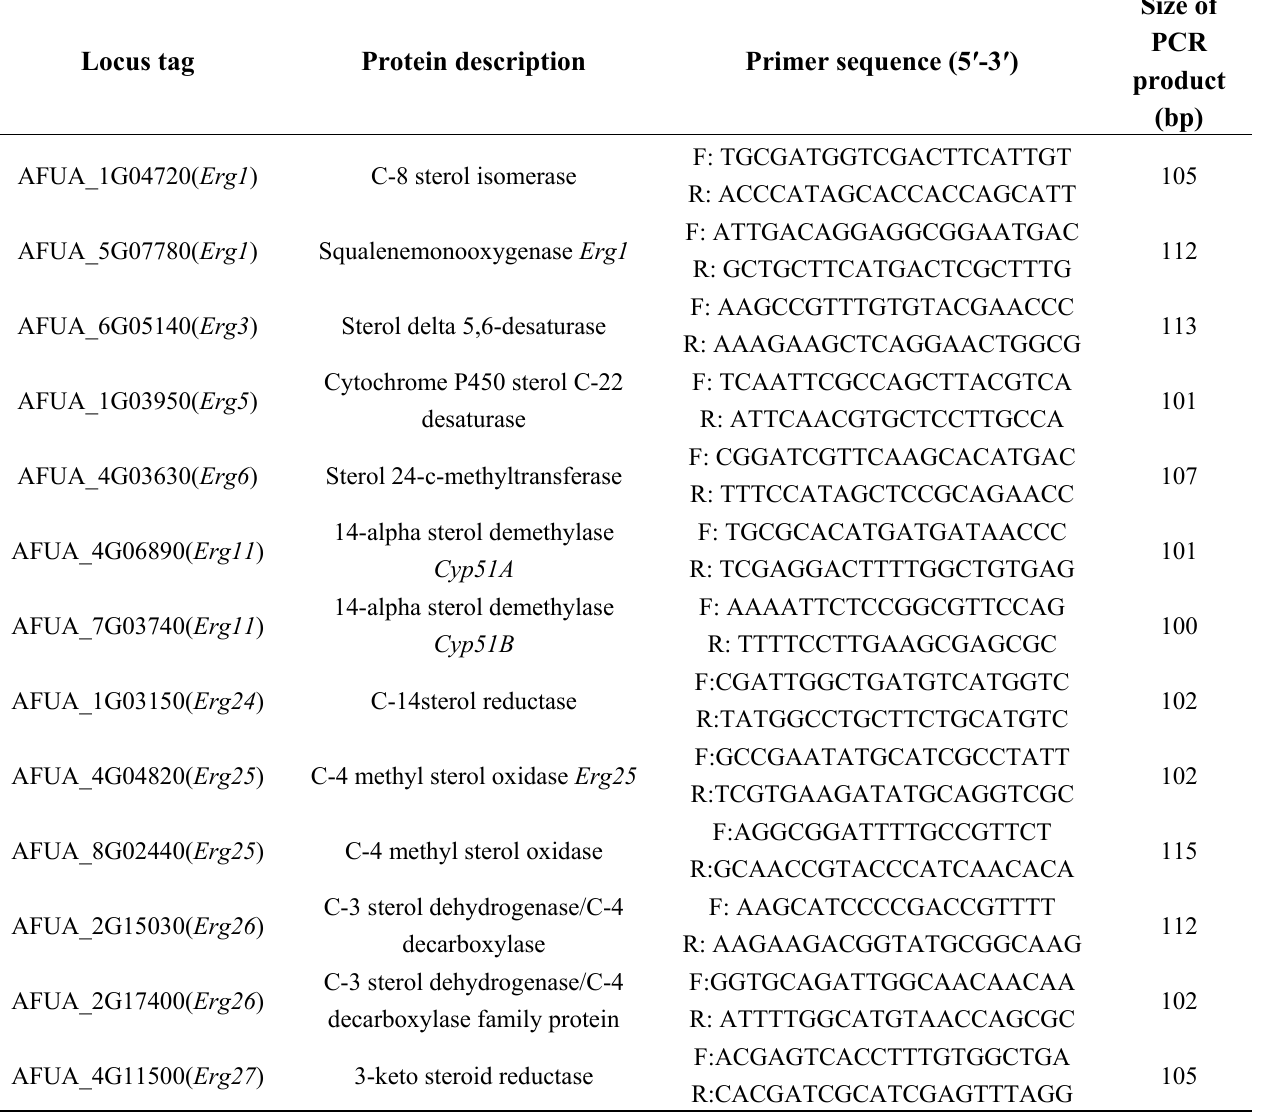
Table 3. Primers used in real-time PCR